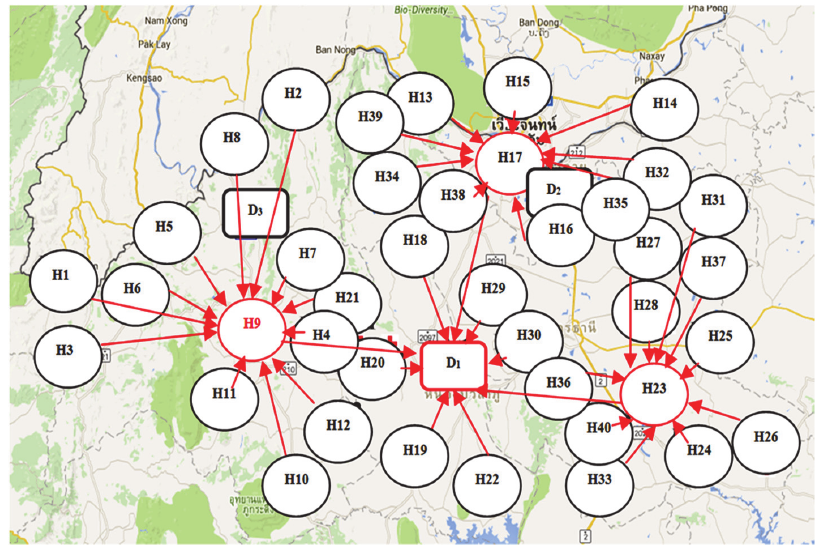
Fig. 5. The suitable transshipment network for